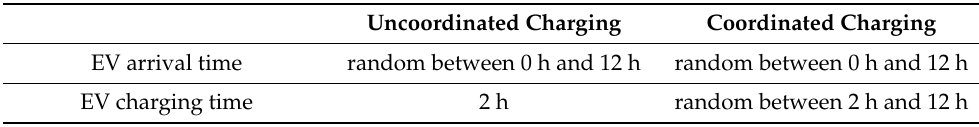
Table 2. Random parameter ranges in conducted statistical